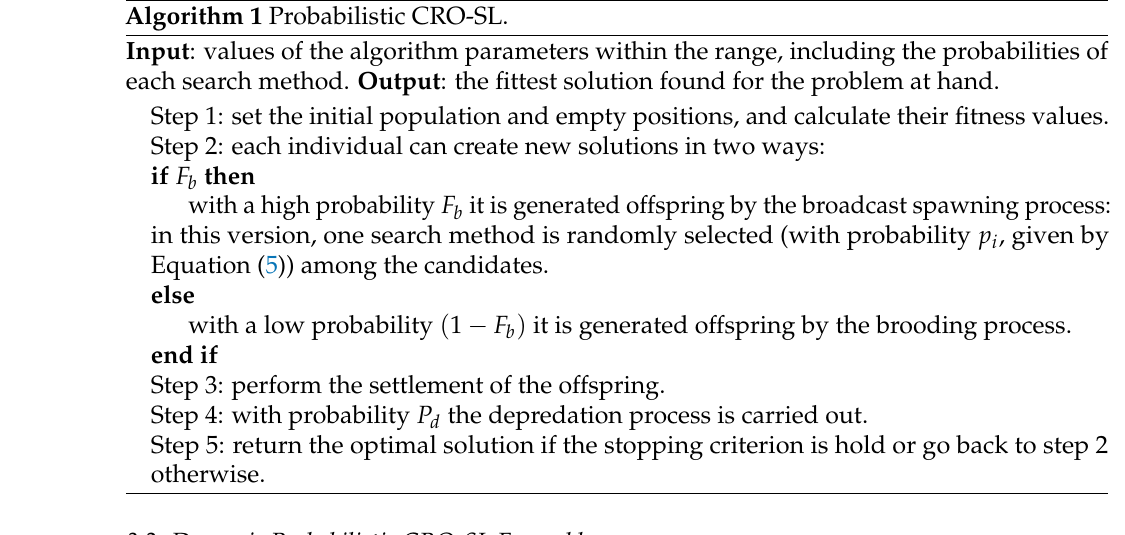
Algorithm 1 Probabilistic